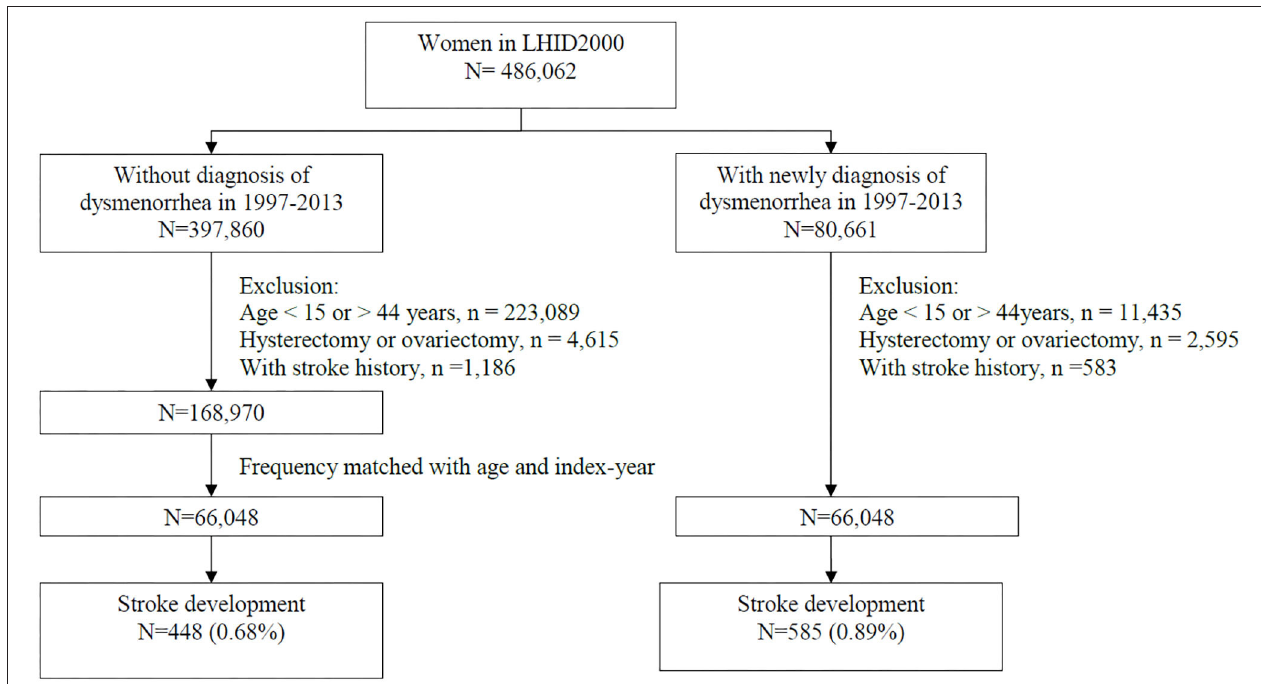
FIGURE 1 | Flowchart for the process of selecting study